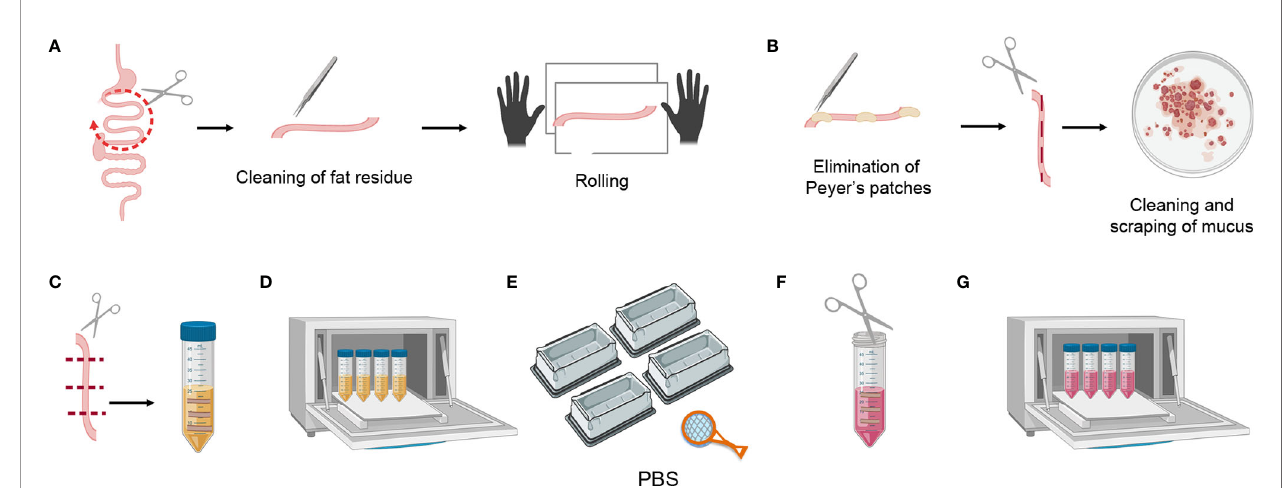
FIGURE 3 | Mouse small intestine tissue processing. (A) Dividing the small intestine into three parts, cleaning the fat residue, and rolling. (B) Eliminating Peyer ’ s patches, cutting longitudinally, scraping the mucus, and cleaning the feces. (C) Transversally cutting the tissue pieces and placing them in a 50 ml falcon containing 20 ml of SI Predigestion Medium. (D) Predigestion of tissue pieces at 37 ° C by means of shaking. (E) Thorough washing of the tissue pieces with PBS 1X. (F) Mincing pieces of small intestine with scissors. (G) Enzymatic digestion of tissue pieces at 37 ° C by